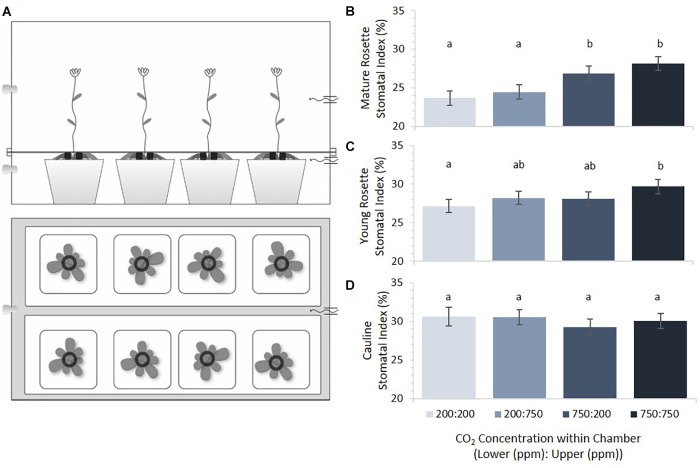
Stomatal indices across plant tissues as a function of [CO2]. (A) Dual-compartment bench top chamber design. Each chamber had two rows of four 5.5 cm2 pots. (B) Mature rosette leaf stomatal index under four CO2 combinations (error bars, s.e.m.; n = 16). (C) Young rosette leaf stomatal index under four CO2 combinations. SI of mature and young rosette leaves in 200 ppm was significantly different from those in 750 ppm (p < 0.0002, p = 0.02, respectively). (D) Cauline leaves under four CO2 combinations. Cauline leaf SI did not significantly differ with [CO2] (p = 0.68). Letters indicate similarity based on a p-value of 0.05 for independent pair-wise comparisons.